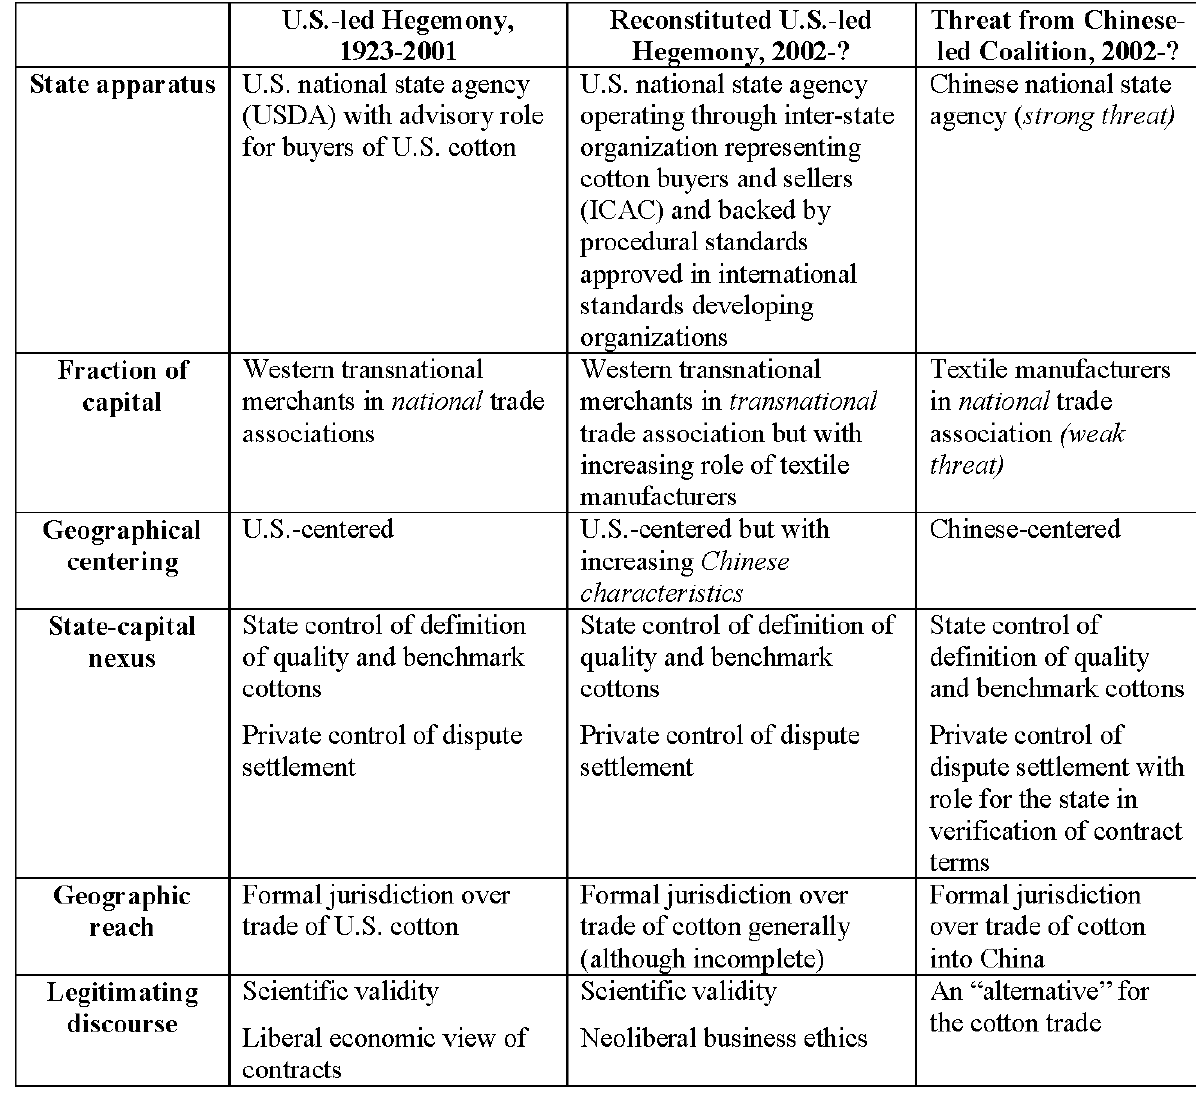
Table 1. The Transformation of Sectoral Hegemonies in the